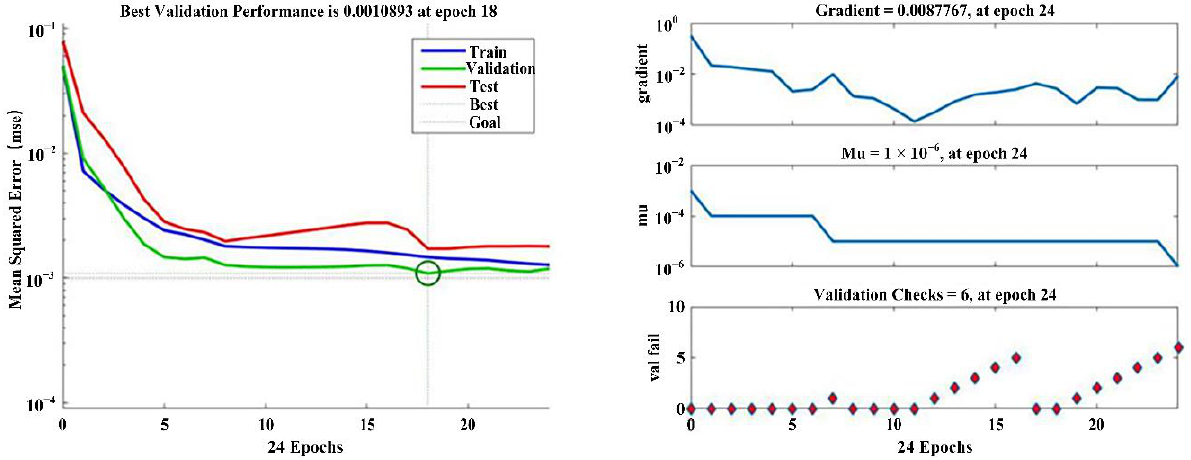
Figure 10. Training error curve of the CWQM model.